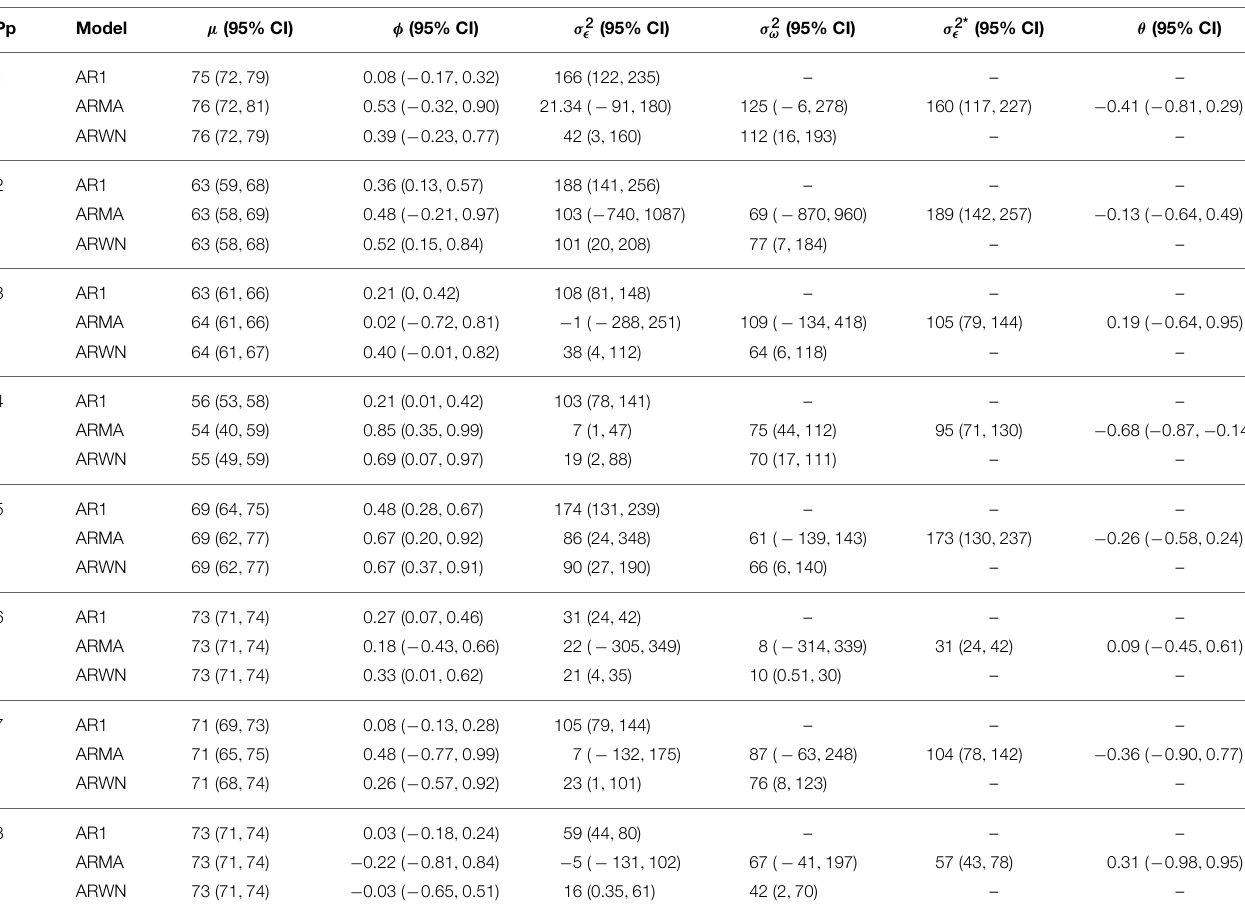
TABLE 1 | Parameter estimates for the AR(1), ARMA(1,1), and AR + WN model for the mood of eight women, estimated with Bayesian